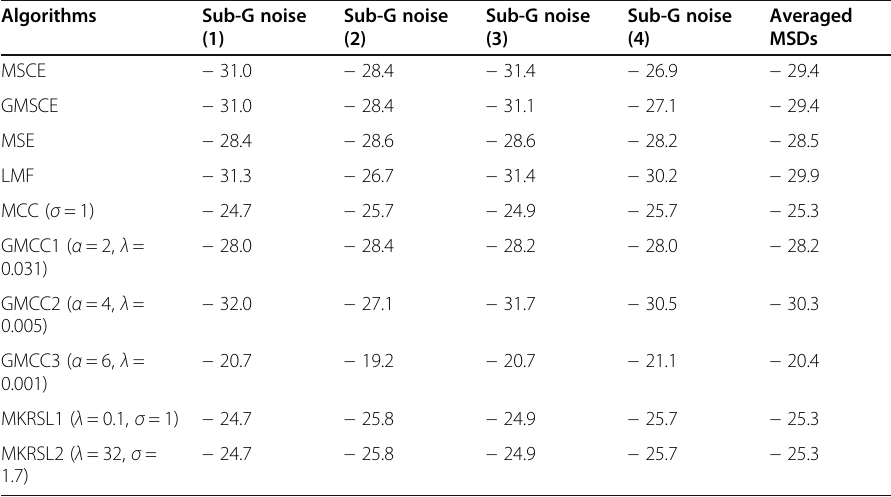
Table 1 The MSDs (dB) of the closed-form solutions of the MSCE, GMSCE, MSE, LMF, and MCC with different sub-Gaussian noises at SNR = 6 dB ( L = 3000) Algorithms Sub-G noise Sub-G noise Sub-G noise Sub-G noise Averaged (1) (2) (3) (4) MSDs MSCE − 31.0 − 28.4 − 31.4 − 29.4 GMSCE − 31.0 − 28.4 MSE − 28.4 LMF − 31.3 − 29.9 MCC ( σ = 1) − 24.7 − 25.7 − 24.9 − 25.7 − 25.3 − 28.0 − 28.4 − 28.2 − 28.0 − 28.2 GMCC1 ( α = 2, λ = 0.031) − 32.0 − 27.1 − 31.7 − 30.5 − 30.3 GMCC2 ( α = 4, λ = 0.005) − 20.7 GMCC3 ( α = 6, λ = 0.001) MKRSL1 ( λ = 0.1, σ = 1) − 24.7 − 25.8 − 24.7 − MKRSL2 ( λ = 32, σ = 1.7)